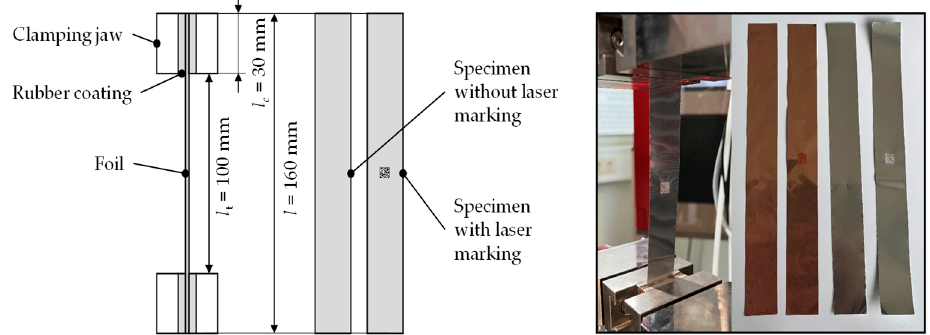
Figure 3. Left: schematic drawing of the tensile test setup and the prepared specimen with and without laser-printed marking/DMC. Right: picture of the test setup and four exemplary prepared specimens for each foil with and without laser marking.